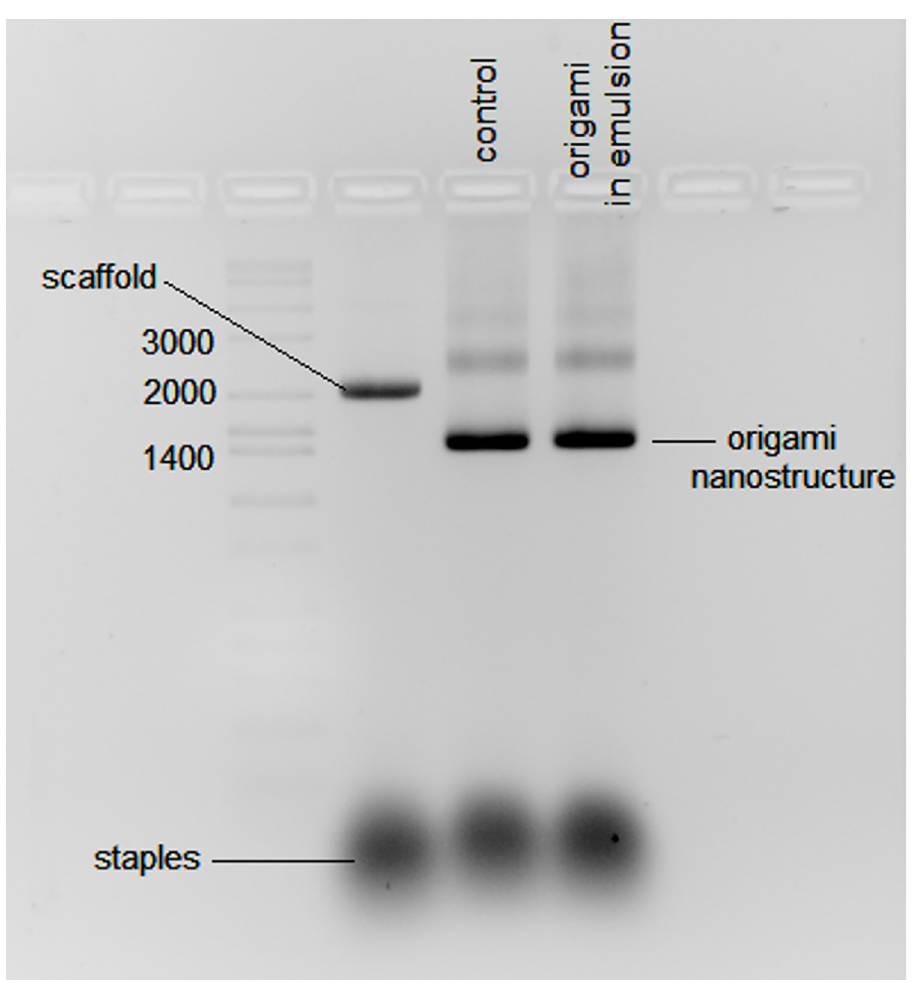
Fig 11. DNA electrophoresis in agarose (2%) showing the formation of origami structures in droplets. The origami products were run in 0.5 X Tris-borate EDTA buffer with ethidium bromide and 6 mM MgCl 2 . The origami structure folded is called “nanostructure PF-2, cuboid with large aperture” from Tilibit Nanosystems. The scaffold, a single-stranded DNA type p7249 isolated from M13mp18 of length 7,249 bases. The staples are a mixture of 208 oligos (S1 Table in S3 File). A sample of the mixture of scaffold and staples not annealed is run for comparison. The origami folded properly shows a distinctive migration on the gel (see S8 and S9 Figs for reference in S3 File). Annealing was done by incubating at 65˚C for 10 minutes then cooled down from 60˚C to 40˚C at a rate of 1˚C per hour.